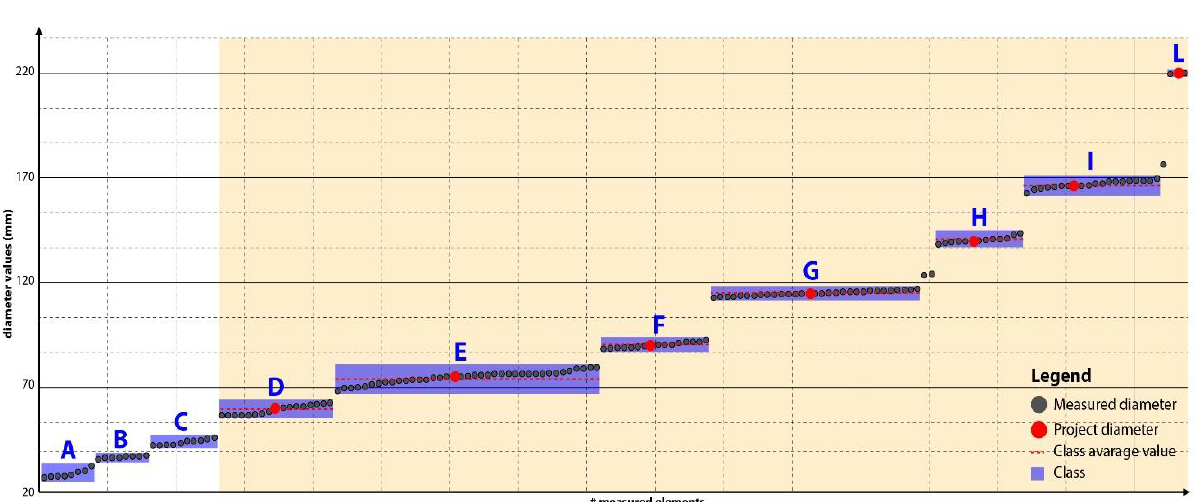
Figure 10: Distribution graph of detected